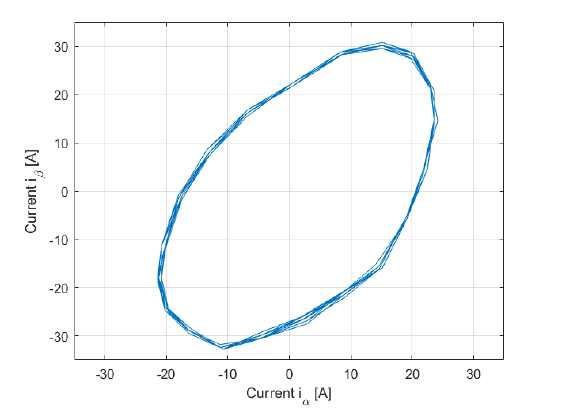
Figure 2. Current ellipse, θ r ≈ 65 ◦